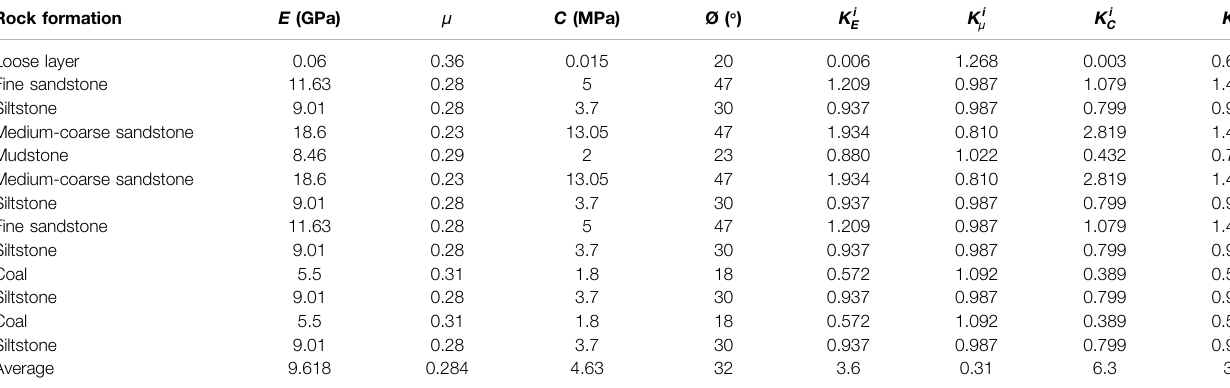
TABLE 1 | Initial mechanical parameters of rock formations. Rock formation Loose layer